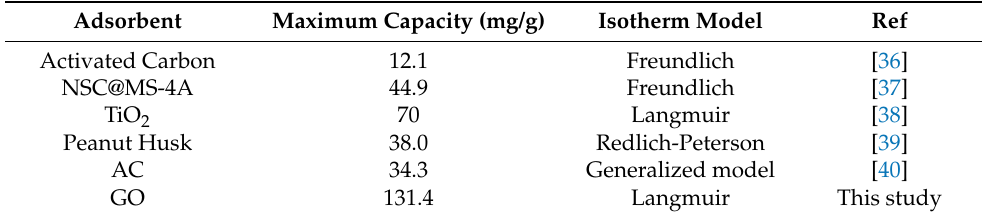
Table 4. Adsorbent isotherm models fitted and capacities for Sr (II)